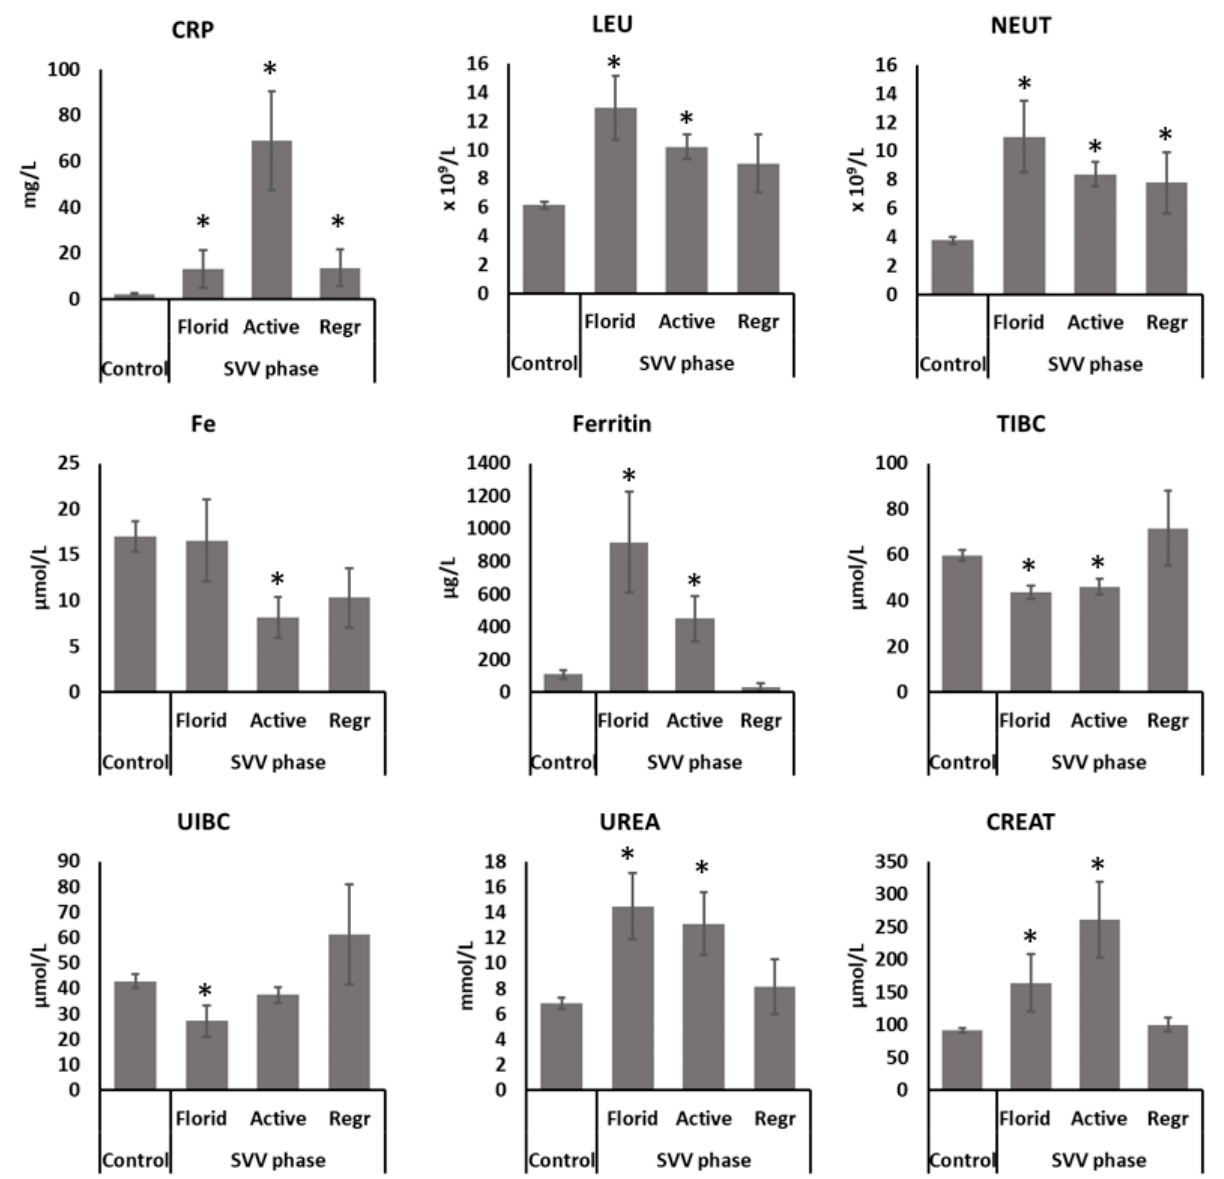
Figure 2. Parameters associated with the development of the disease. Significance * p < 0.05 compared to healthy controls.